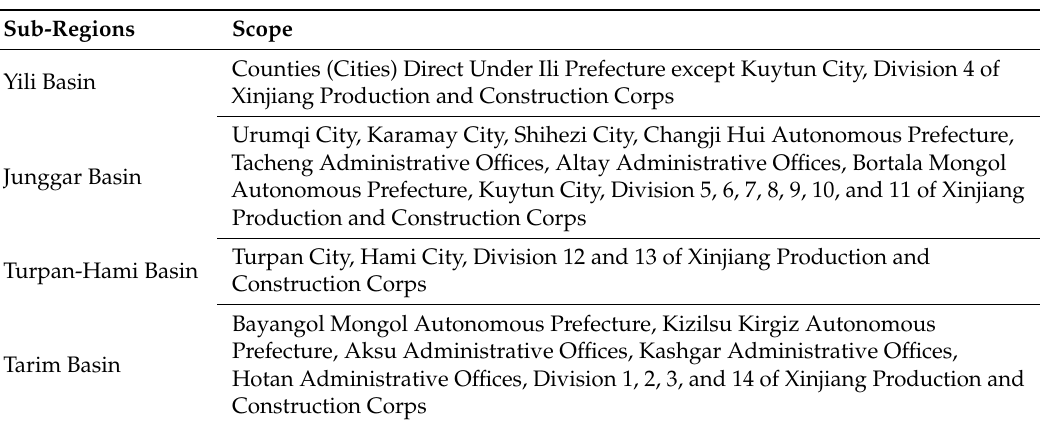
Table note: The data are provided by Statistics Bureau of Xinjiang Uygur Autonomous Region [48].